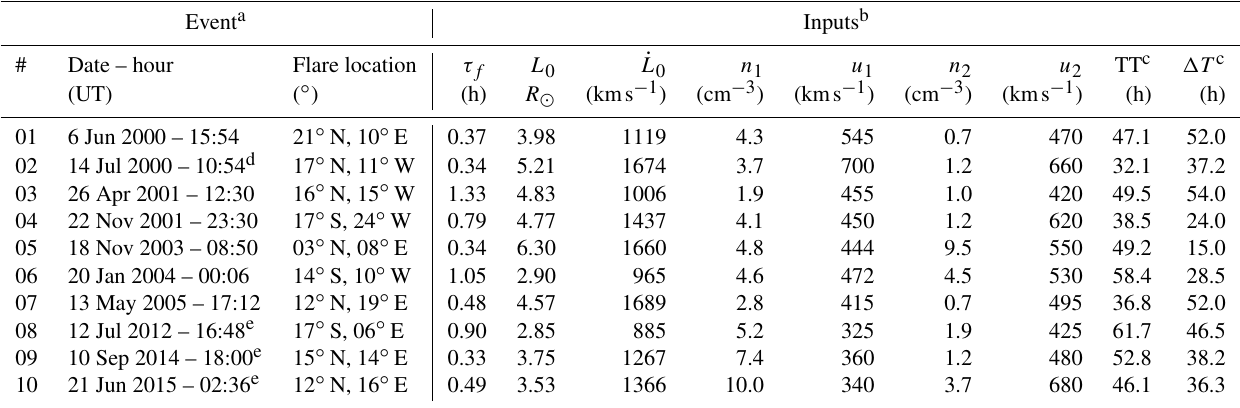
Table 1. Input data for our analysis. From left to right: event number, CME detection date and time, associated active region position on the solar disk (latitude and longitude), rise time of associated solar flare, initial position and speed of the CME leading edge, in situ values of the proton density and speed of solar wind ahead (index “1”) and behind (index “2”) CMEs, and travel and transit times. Event